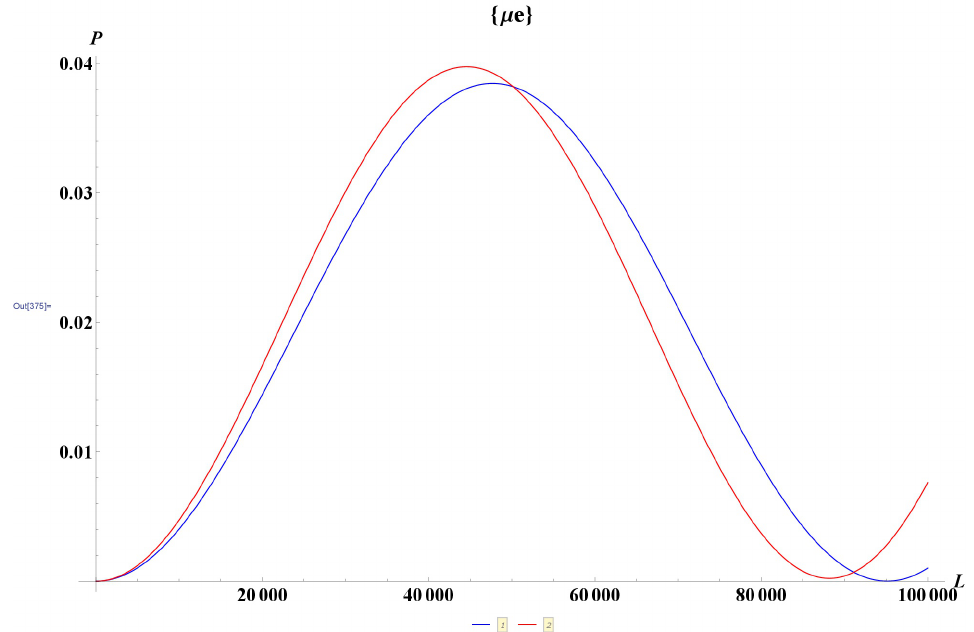
Figure 5. Same analysis of Figure 1, but for LIV parameters δ f 32 = δ f 21 = 4.5 × 10 − 27 and for neutrino energy beam E = 100 GeV. Baseline L in km [73].